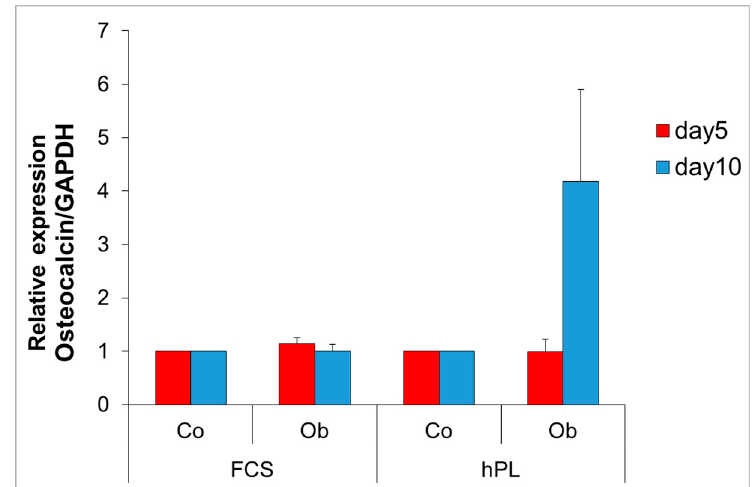
Figure 4. Relative gene expression levels of human osteocalcin transcript levels by quantitative PCR.